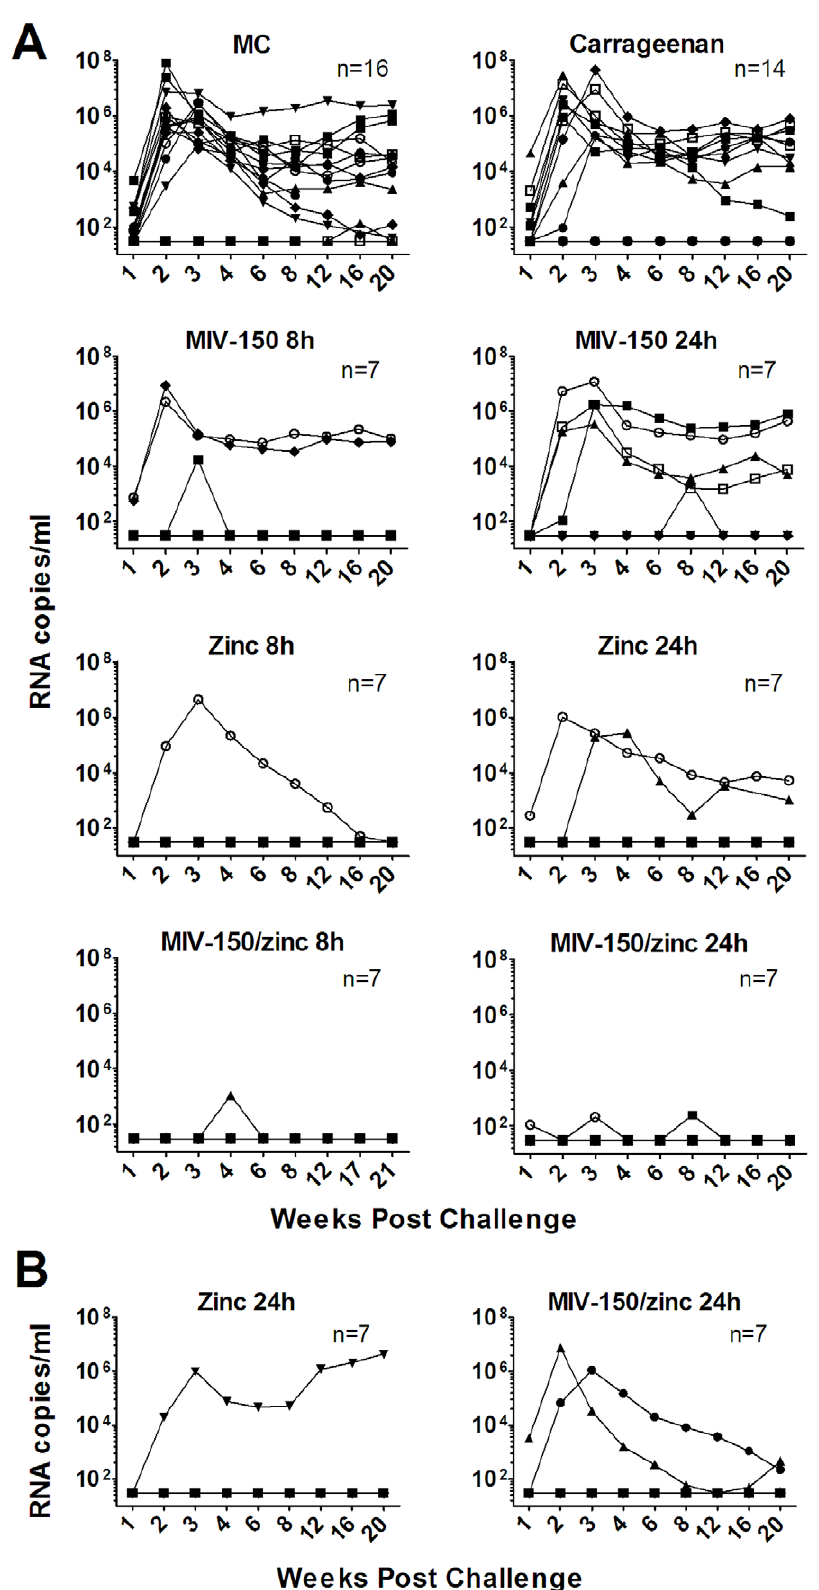
Figure 2. Repeated daily application of 50 m M MIV-150/zinc acetate protects fully for at least 24 h. A. Animals were treated daily for 2 weeks with either MC placebo, carrageenan vehicle (PC-515), or carrageenan gel containing 50 m M MIV-150 (PC-815), 14 mM zinc acetate dihydrate (PC-707), or 50 m M MIV-150/14 mM zinc acetate dihydrate (PC-1005). SHIV-RT was then applied vaginally 8 or 24 h after the last gel. The data within